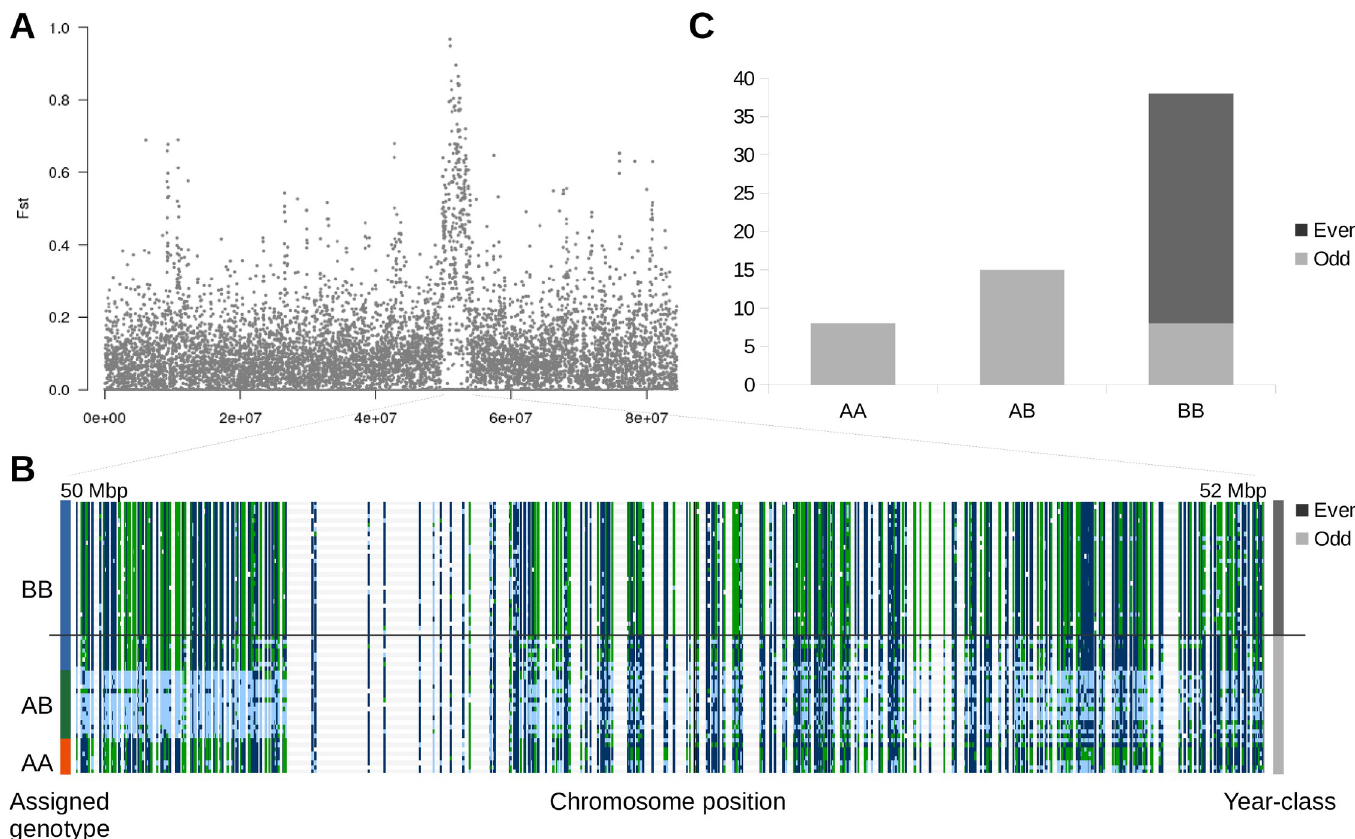
Fig 6. Chromosome LG15_El12.1–15.1 Fst peak. A) A Manhattan plot of 10 kbp sliding-window Fst values between odd and even-year pink salmon lineages on chromosome LG15_El12.1–15.1. B) Genotypes visualized in IGV. Each row represents an individual pink salmon and each column represents a nucleotide variant (dark